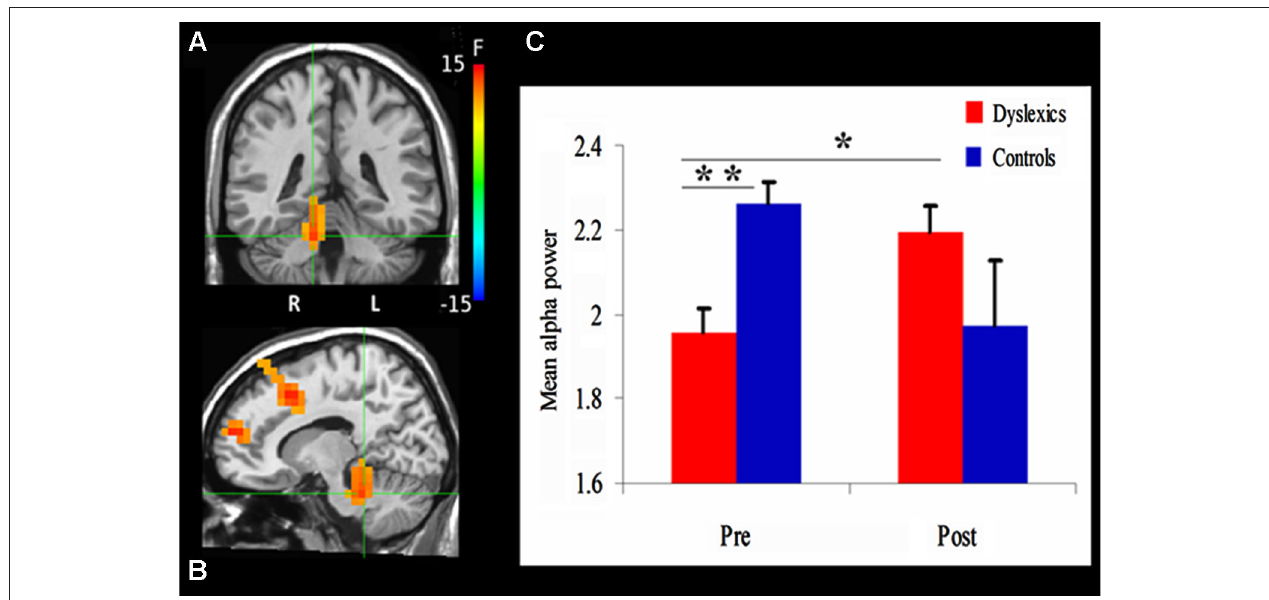
FIGURE 3 | Changes in alpha power. (A) and (B) demonstrate the significant clusters resulting from the Group (dyslexics, controls) by Training (pre-training, post-training) interaction. Voxels are colored by the F statistics, overlaid on coronal (A) and sagittal (B) views. The statistical map is thresholded at p <